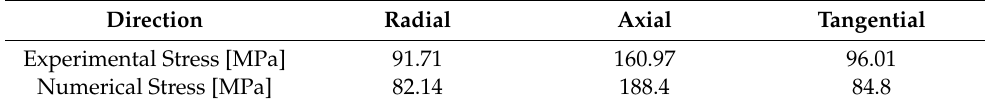
Table 3. Experimental values of fracture stress at ρ = 1.8 g/cm 3 and v 1 = 0.5 mm/min. Direction